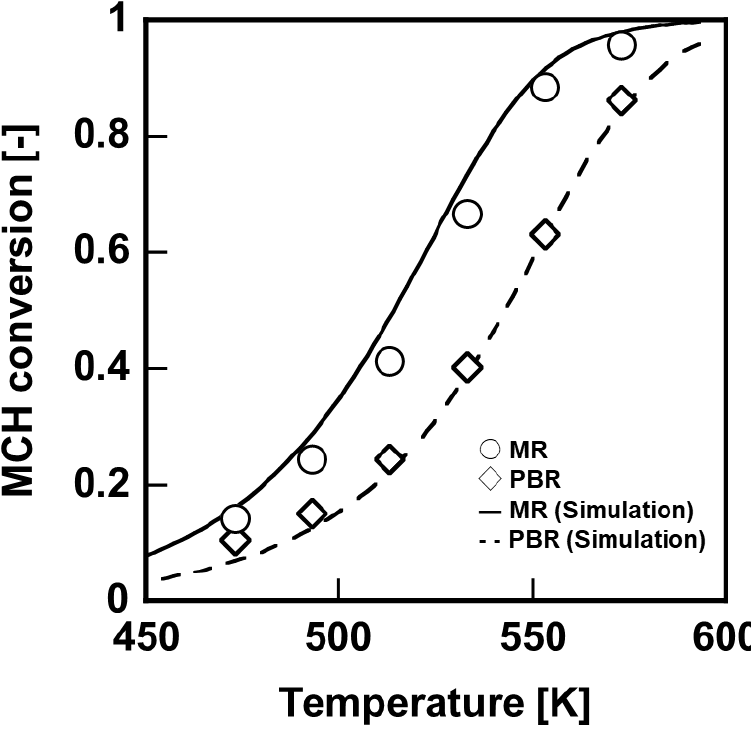
Figure 5. Temperature dependence of the MCH conversion to compare between packed–bed reactor (PBR) and membrane reactor (MR) which was included in a single silica membrane.